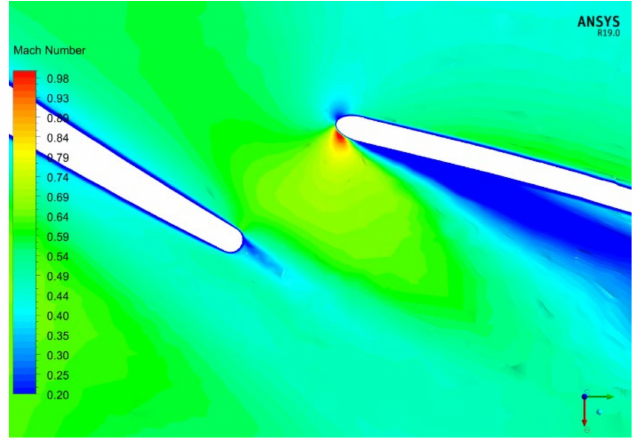
Figure 15. Excessive incidence on the exducer leading edge, m r = 0.32.